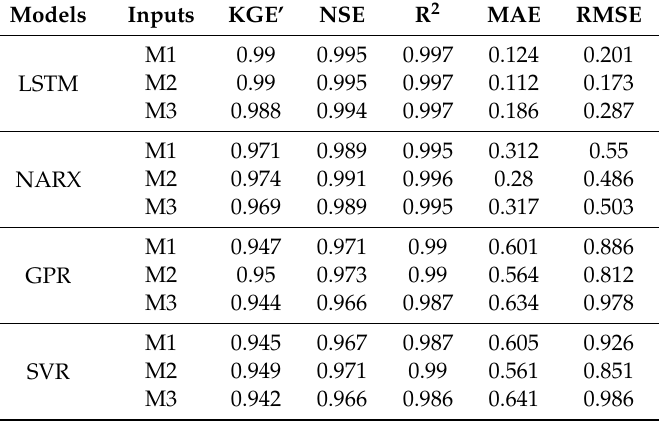
Table 6. Performance of machine learning (ML) models with di ff erent input combinations during the testing phase, all inputs (M1), all inputs without precipitation (M2), and all input without SCA